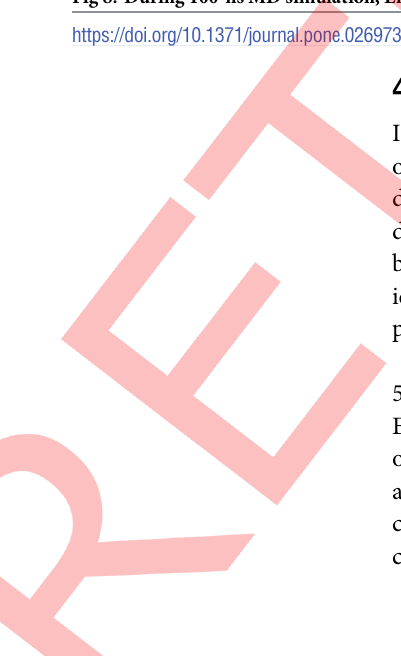
Fig 8. During 100-ns MD simulation, Endothlien-1 interacts with the compounds as a protein-ligand